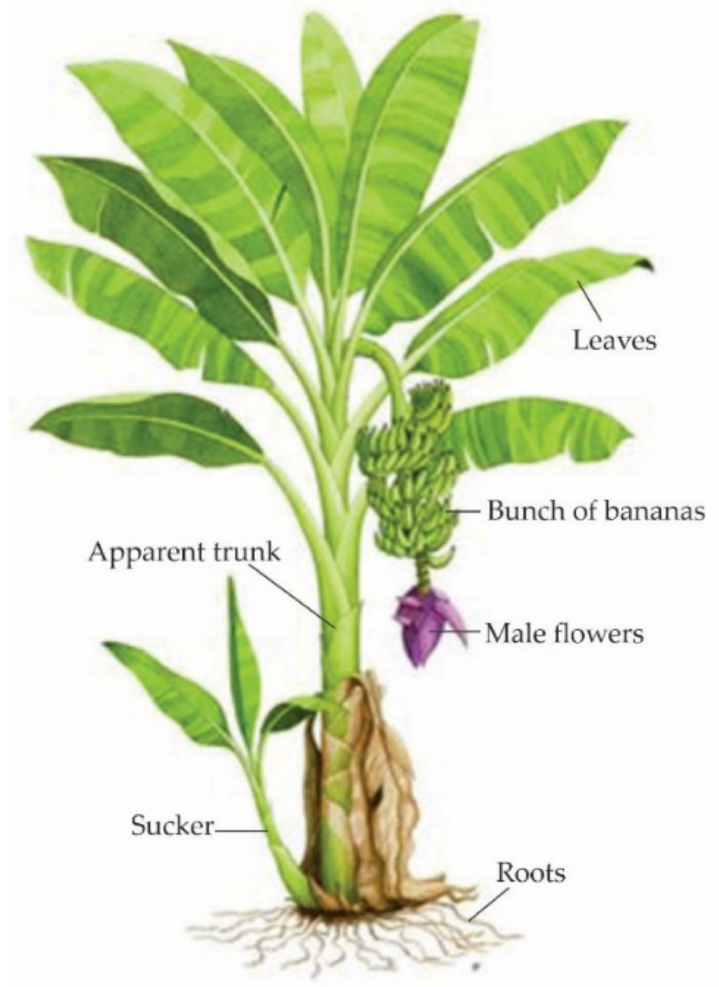
Figure 4. Parts of the banana plant. Adapted from